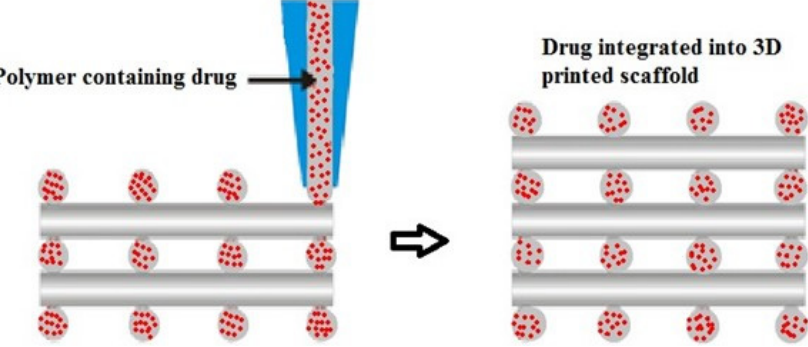
Figure 22. The 3D printing method. Reproduced with permission from [1].